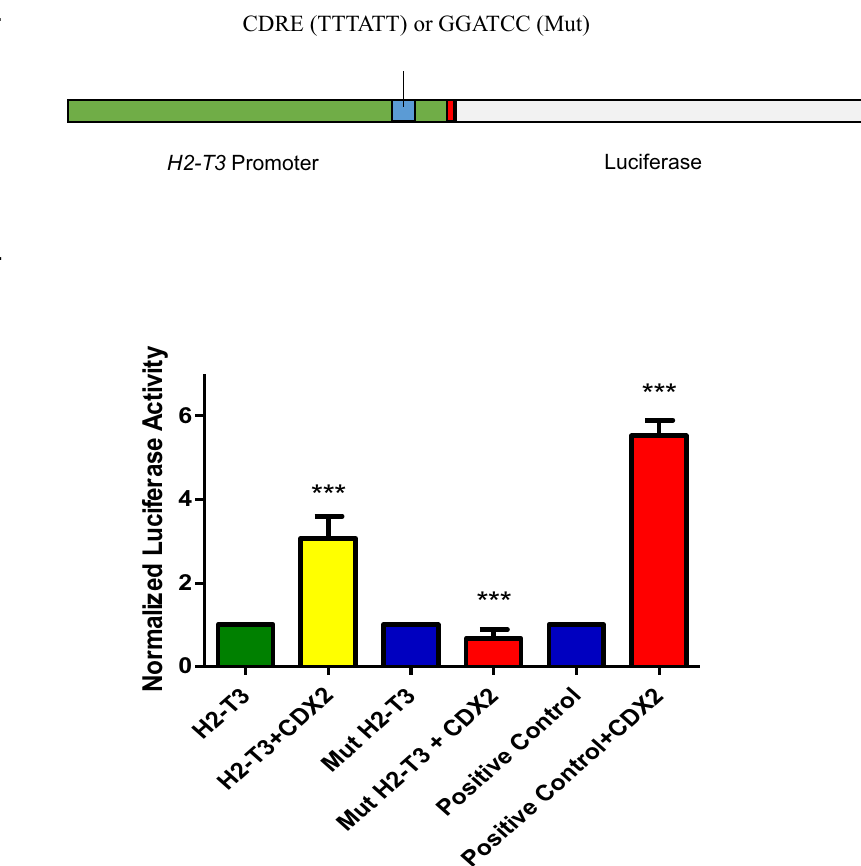
Figure 4. Regulation of H2-T3 by Cdx2. ( A ) A 1.9 Kb genomic region upstream of the transcriptional start site was used to generate a luciferase reporter (H2-T3) with a wild type (TTT ATT ) or mutant (GGA TCC;Mut) CDRE. Image was drawn using Microsoft PowerPoint software. ( B ) Reporters were transfected into C2BBE1 cells with or without a Cdx2 expression vector and luciferase activity assessed 48 h post-transfection. Graph and statistics were generated using Graphpad Prism 5.0. Bars represent mean luminescence normalized to cells transfected without a Cdx2 expression vector. Significance was calculated by one-way ANOVA (n = 6, *** p <